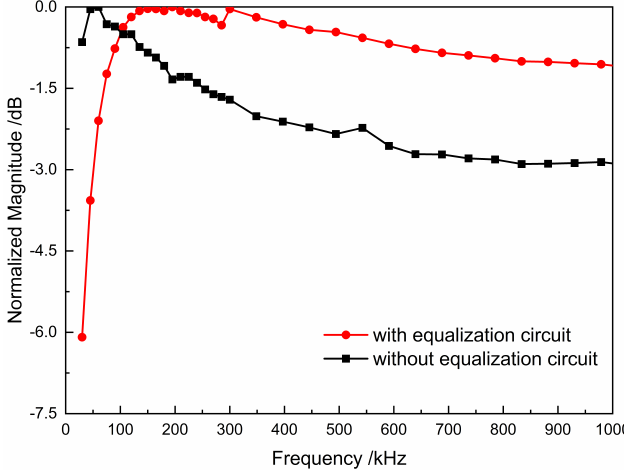
Figure 6. Frequency response of the transmitter with/without equalization circuit.